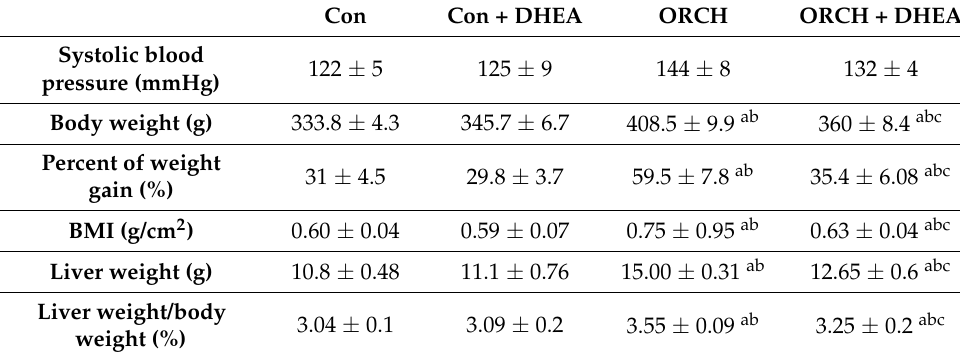
Table 1. Effect of DHEA on Systolic blood pressure, body weight, percent of weight gain, body mass index (BMI), liver weight, and liver \ body weight % in orchidectomized rats.